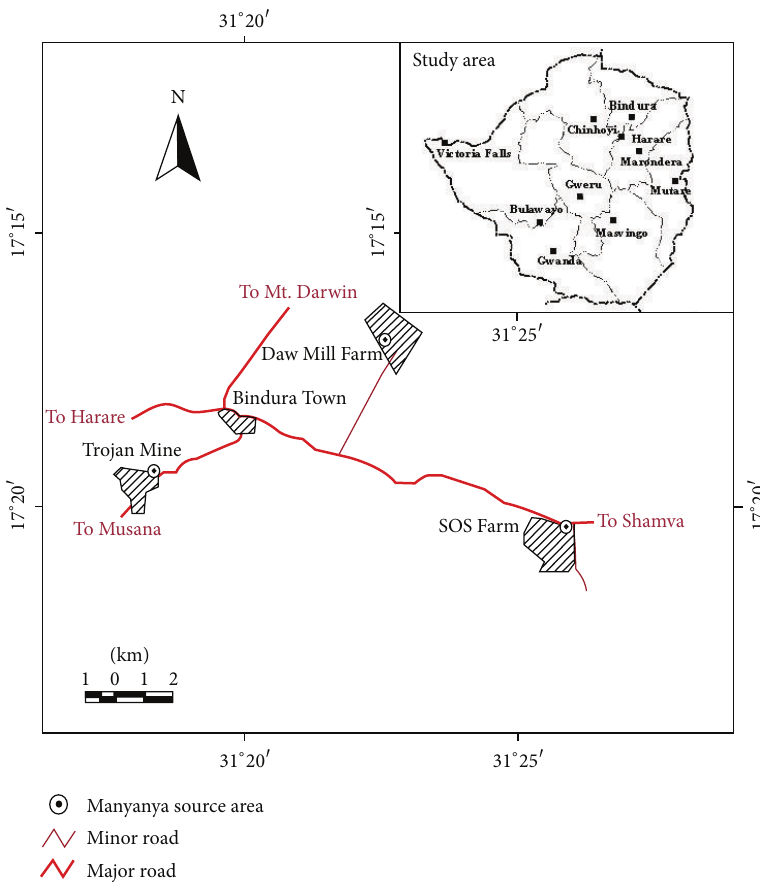
Figure 2: BUSE GIS Department: location of source areas for Dioscorea steriscus